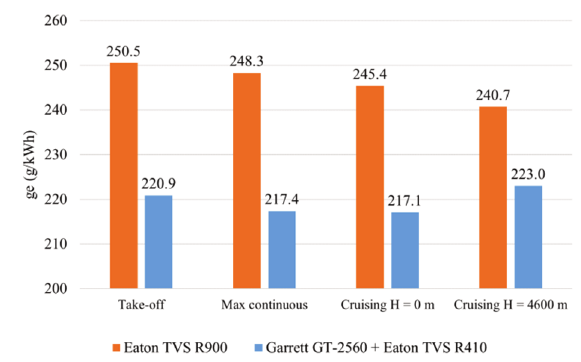
Fig. 4. Comparison of the specific fuel consumption for two analyzed variants The power consumed by the compressor for the consid- ered cases is shown in Fig. 5. For the case with the Eaton TVS R900 compressor, the power consumed by the com- pressor decreased with the decreasing power generated by Fig. 6. Comparison of the effective pressure for two analyzed variants the engine. For the variant with a turbocharger, the con- sumed power was reduced by more than half for the take- off power operating point and the continuous maximum power point. For cruising power at 4600 m, this value de- creased by 32%.